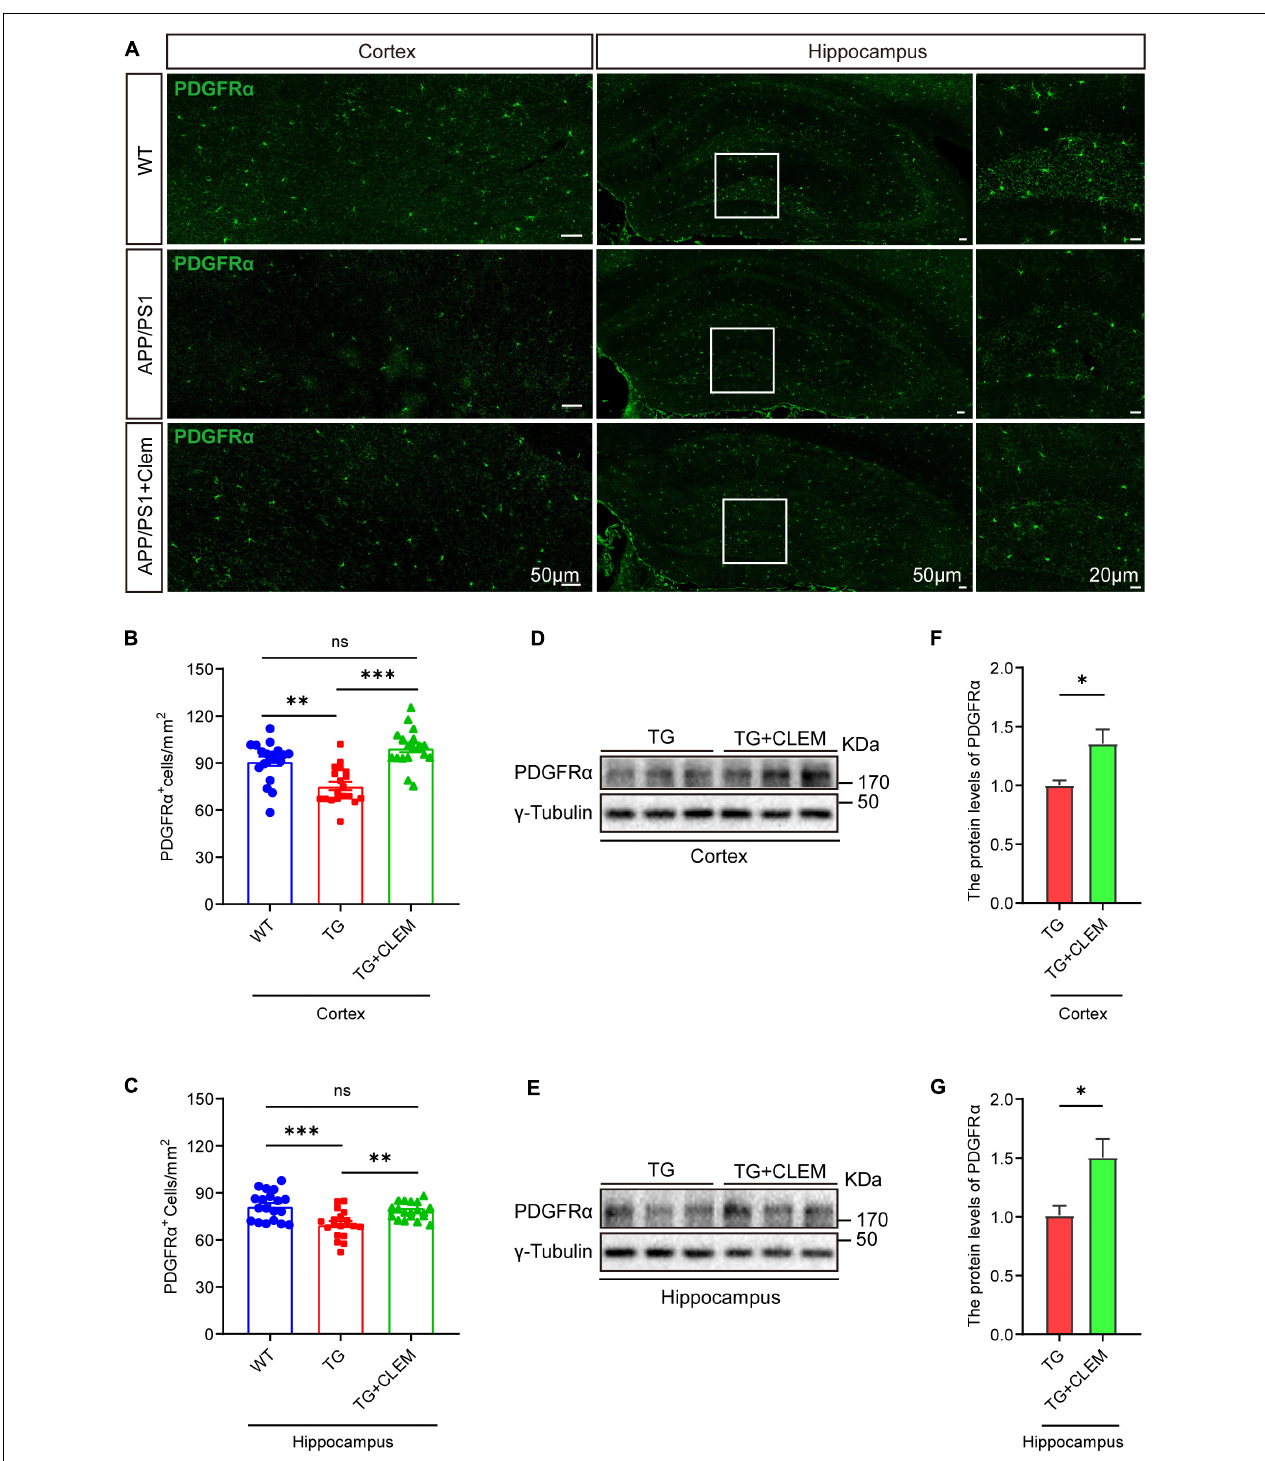
FIGURE 3 | Chronic treatment of clemastine increases number of OPCs in aged APP/PS1 mice brain. (A) Confocal images of immunolabeling of PDGFR α (green) in hippocampus/cortex of WT; APP/PS1 and APP/PS1 mice treated with clemastine. White box indicates magnified area of hippocampus. (B,C) Quantification of number of PDGFR α + cells in hippocampus (B) and cortex (C), respectively. (D,E) Western analysis of PDGFR α levels in hippocampus (D) or cortex (E) of APP/PS1 or APP/PS1 mice treated with clemastine; γ -tubulin was served as loading control. (F,G) Quantification of replicated results shown in (D,E) , respectively. Ratio values were calculated as “PDGFR α / γ -Tubulin” and normalized to ratio of APP/PS1 mice. Values shown represent mean ± SE. ∗ p < 0.05, ∗∗ p < 0.01, ∗∗∗ p < 0.001, n = 4 mice per group for (B,C) and n = 3 mice per group for (F,G) , one-way analysis of variance with Student’s t -test.